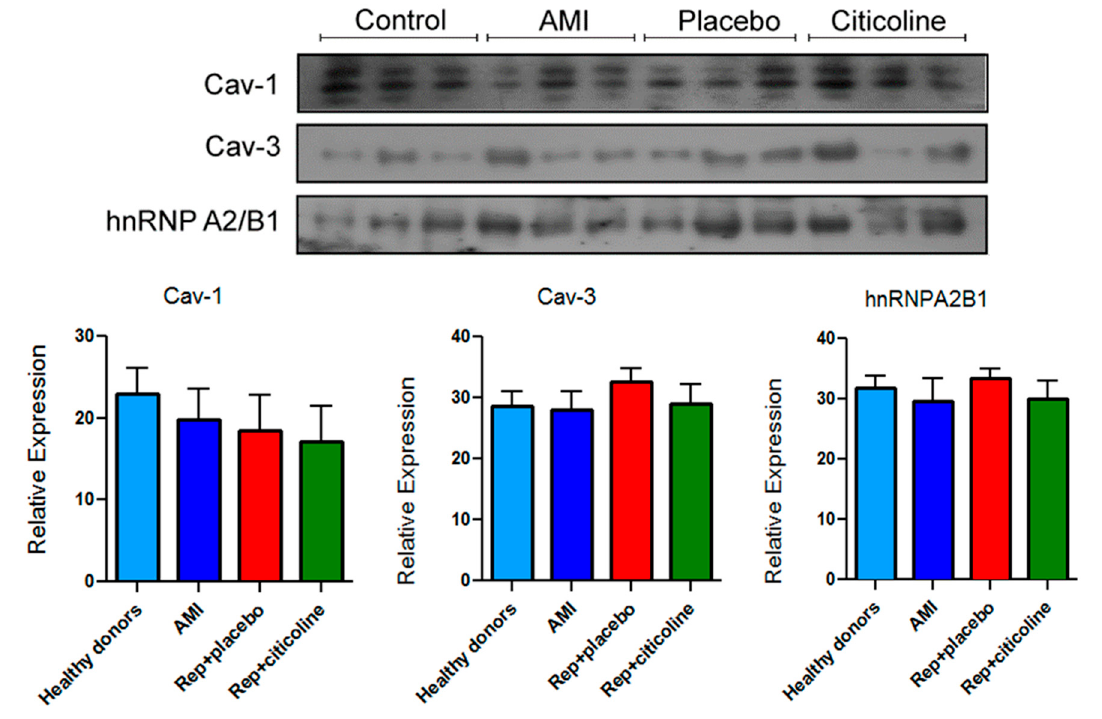
Figure 5. Immunodetection of proteins related to RNA trafficking process into exosomes. Representative images of Caveolin-1 (Cav-1), Caveolin-3 (Cav-3), and hnRNPA2B1 content as well as their densitometric analysis. Results are shown as mean ± SEM of exosome samples from different patients in each group ( n = 9).